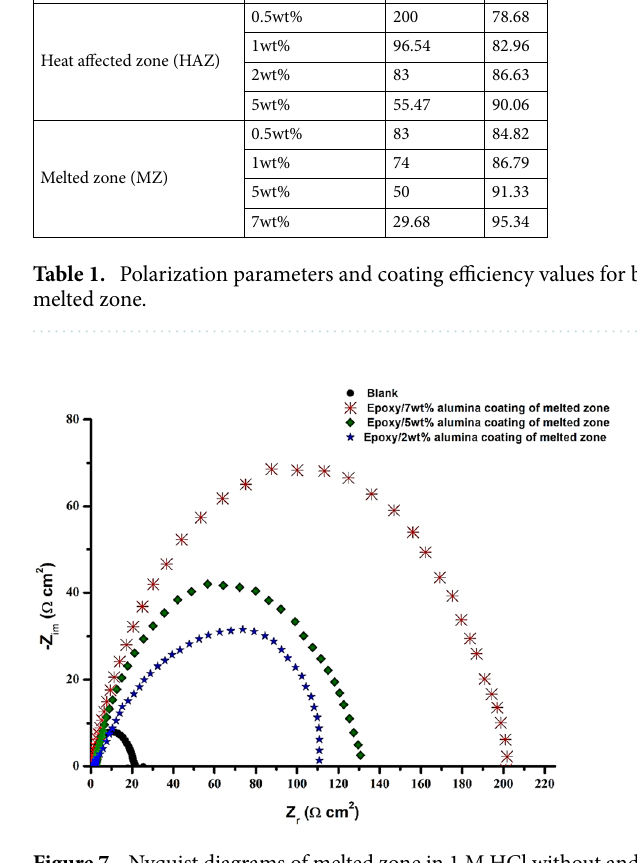
Figure 7. Nyquist diagrams of melted zone in 1 M HCl without and with coating containing various concentrations of